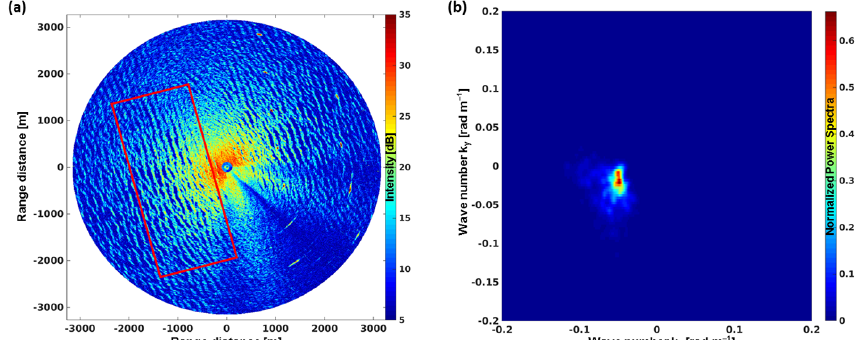
Figure 2. Radar intensity image acquired in the polar mode at research platform Fino-3 on 11 August 2014 at 10:00UTC (a) . The wave spectrum was retrieved from a 120s long radar intensity image sequence (b) .